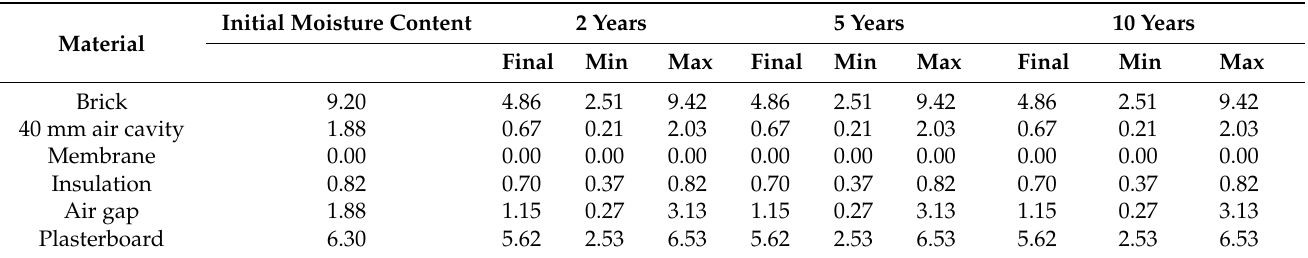
Table 9. Water content properties of 7 − star clay masonry veneer wall—north, south, and east orientation (kg/m 3 ).